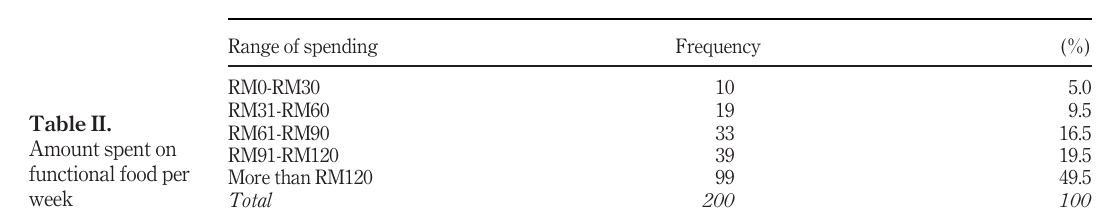
Table I. Individual salary